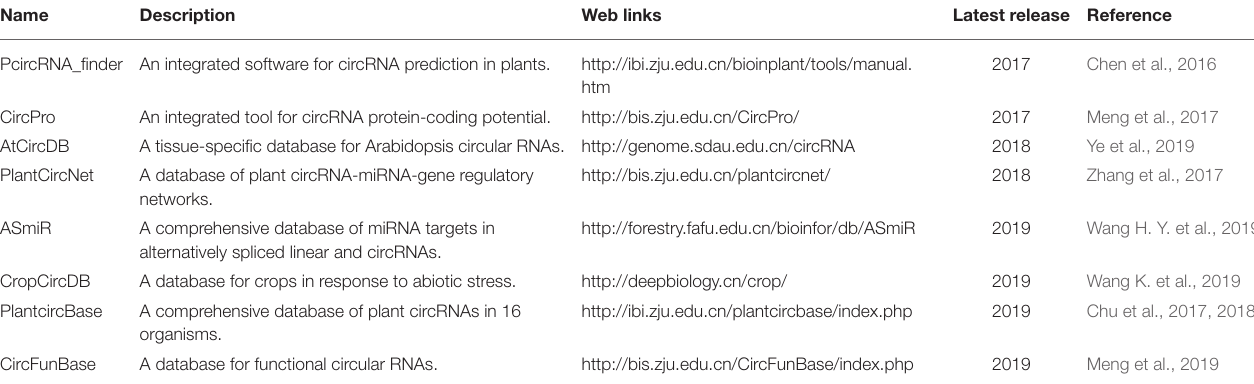
TABLE 1 | An overview of bioinformatics resources for plant circRNAs.